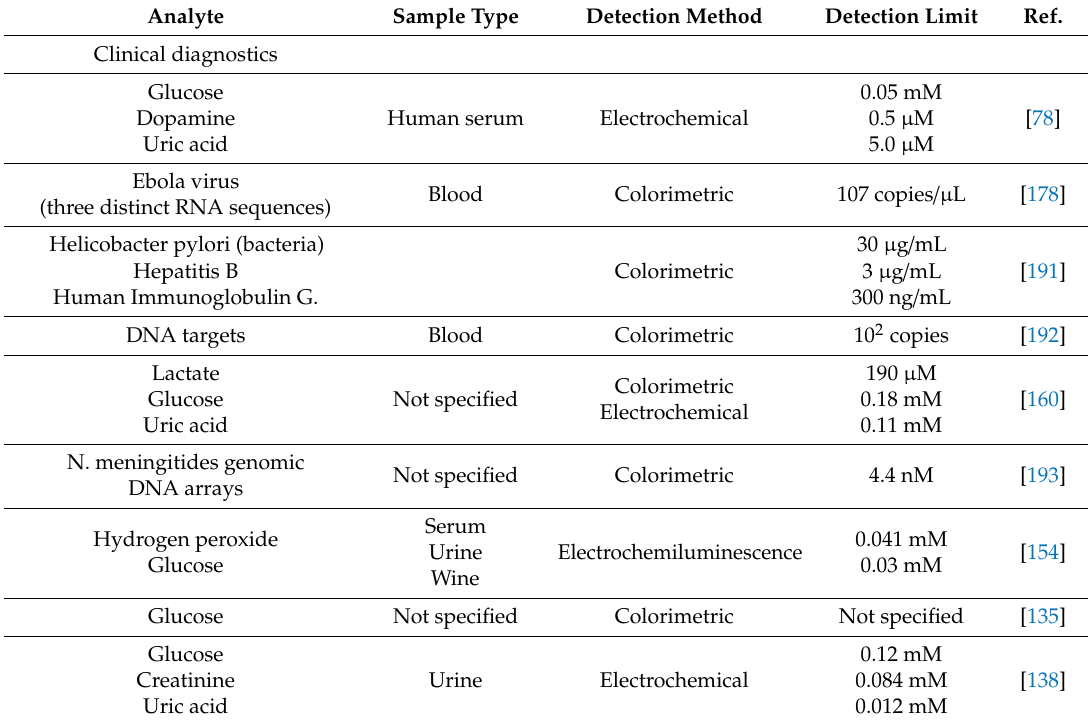
Table 2. Recent applications of µ PADs for high-throughput analyses in clinical diagnostics, drug detection, screening, environmental monitoring, and food and beverage